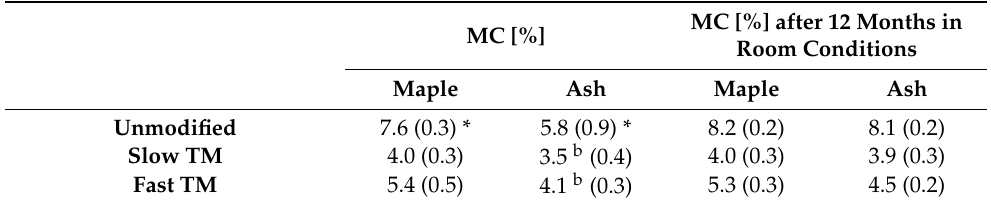
Table 1. Moisture content of unmodified and thermally modified maple and ash wood, after treatment and after 12 months in room conditions (20 ± 2 ◦ C/44 ± 8%).